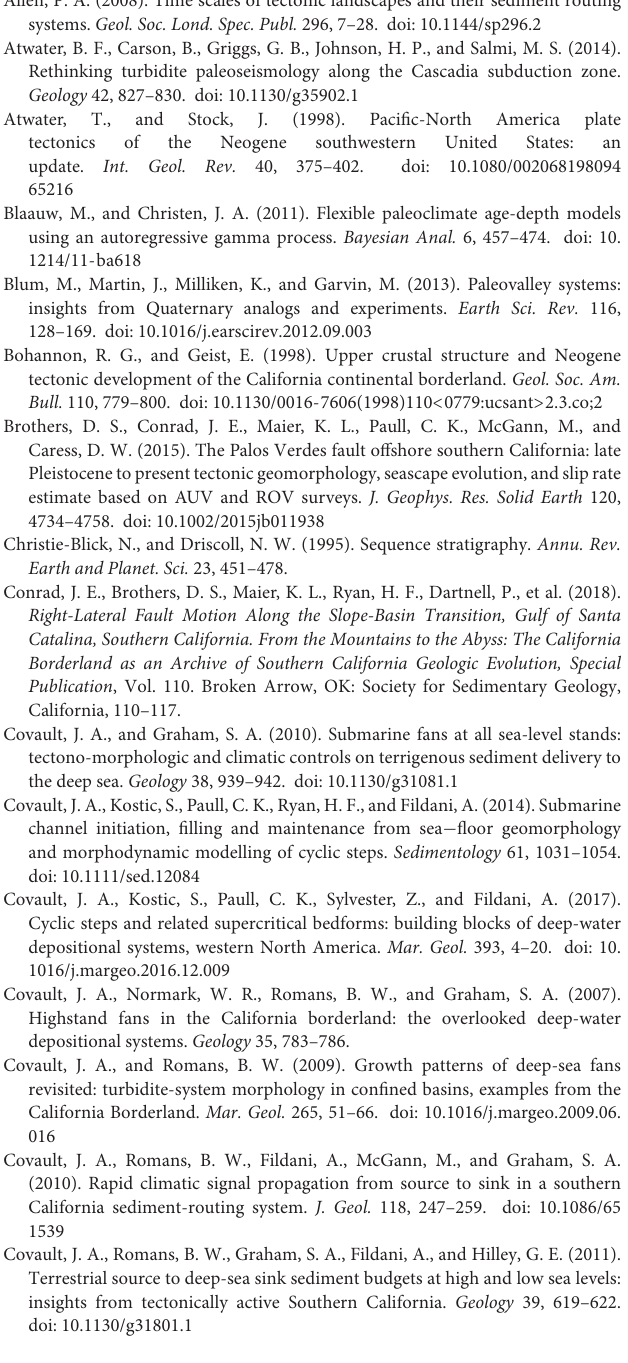
FIGURE S3 | Strike slices along the San Onofre margin. The shallowest slice is at the top and the deepest slice is at the bottom. Locations of lines are shown in Figure 1 . For interpreted seismic profiles, see Figure 6